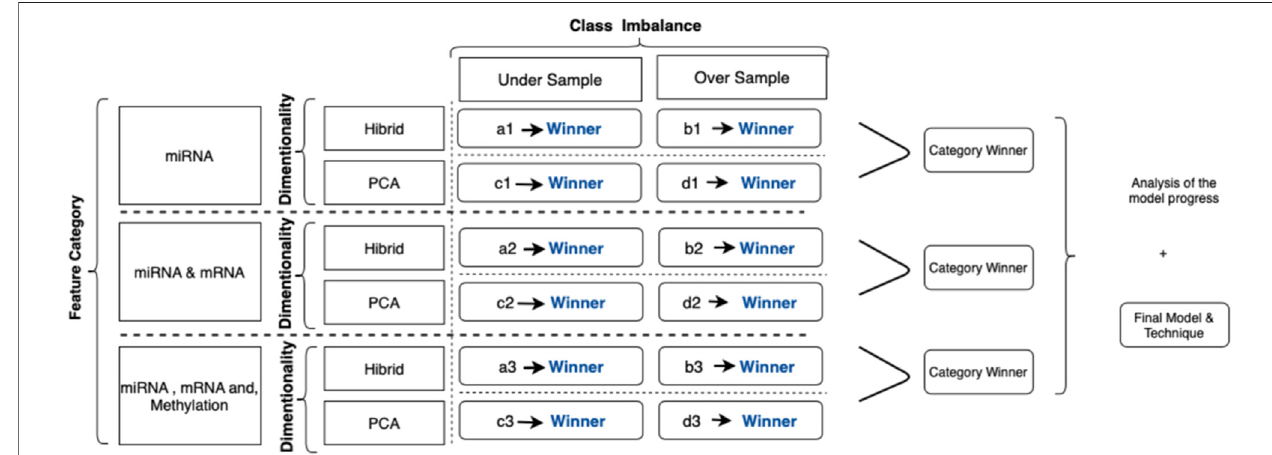
FIGURE 4 | Illustration for category-based analysis with techniques applied: each evaluation criterion is represented with a code. For example, (a1) represents the predictive models by using miRNA signatures with the hybrid method, that is, the random forest, to calculate feature importance undersampling for the class imbalance solution. Similarly, (d3) represents the outcomes of models applied to predict metastasis using signi fi cant miRNA, mRNA, and methylation biomarkers using PCA as a dimensional solution and SMOTE as a class imbalance solution.